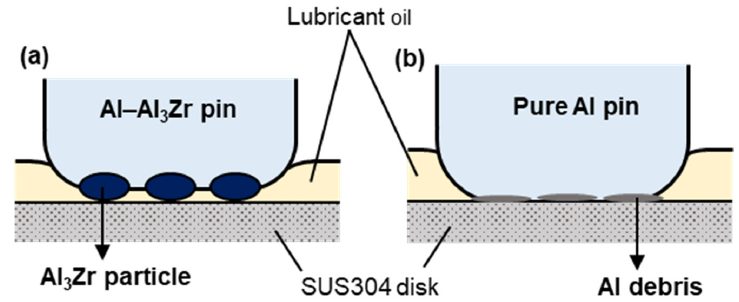
Figure 11. Schematic illustration of the wear mechanisms of the ( a ) Al–Al 3 Zr composite and ( b ) pure Al pin used in the SUS304 disc as the counter material.